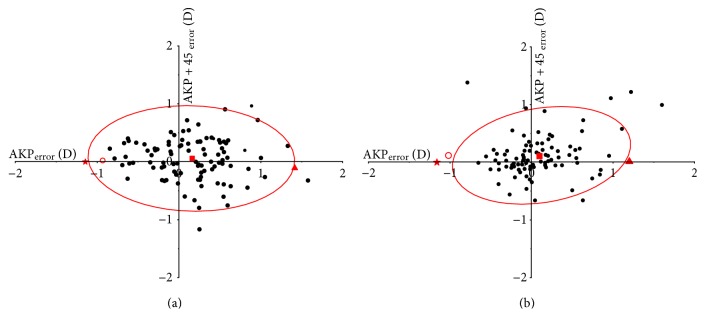
Bivariate analysis of the error of treatment in anterior corneal astigmatism (ACA) (a) and total ocular astigmatism (TOA) (b) following wavefront-guided SBK in 100 eyes. Mean values and 95% confidence areas (solid) of the combined means, expressed as polar values in the preoperatively steeper meridian. The means are shown as follows: preoperative value = triangle to the right; target-induced astigmatism (TIA) = star to the left; surgically induced astigmatism (SIA) = circle to the left; the combined mean of the error of treatment = square in the middle. All values are given in diopters.